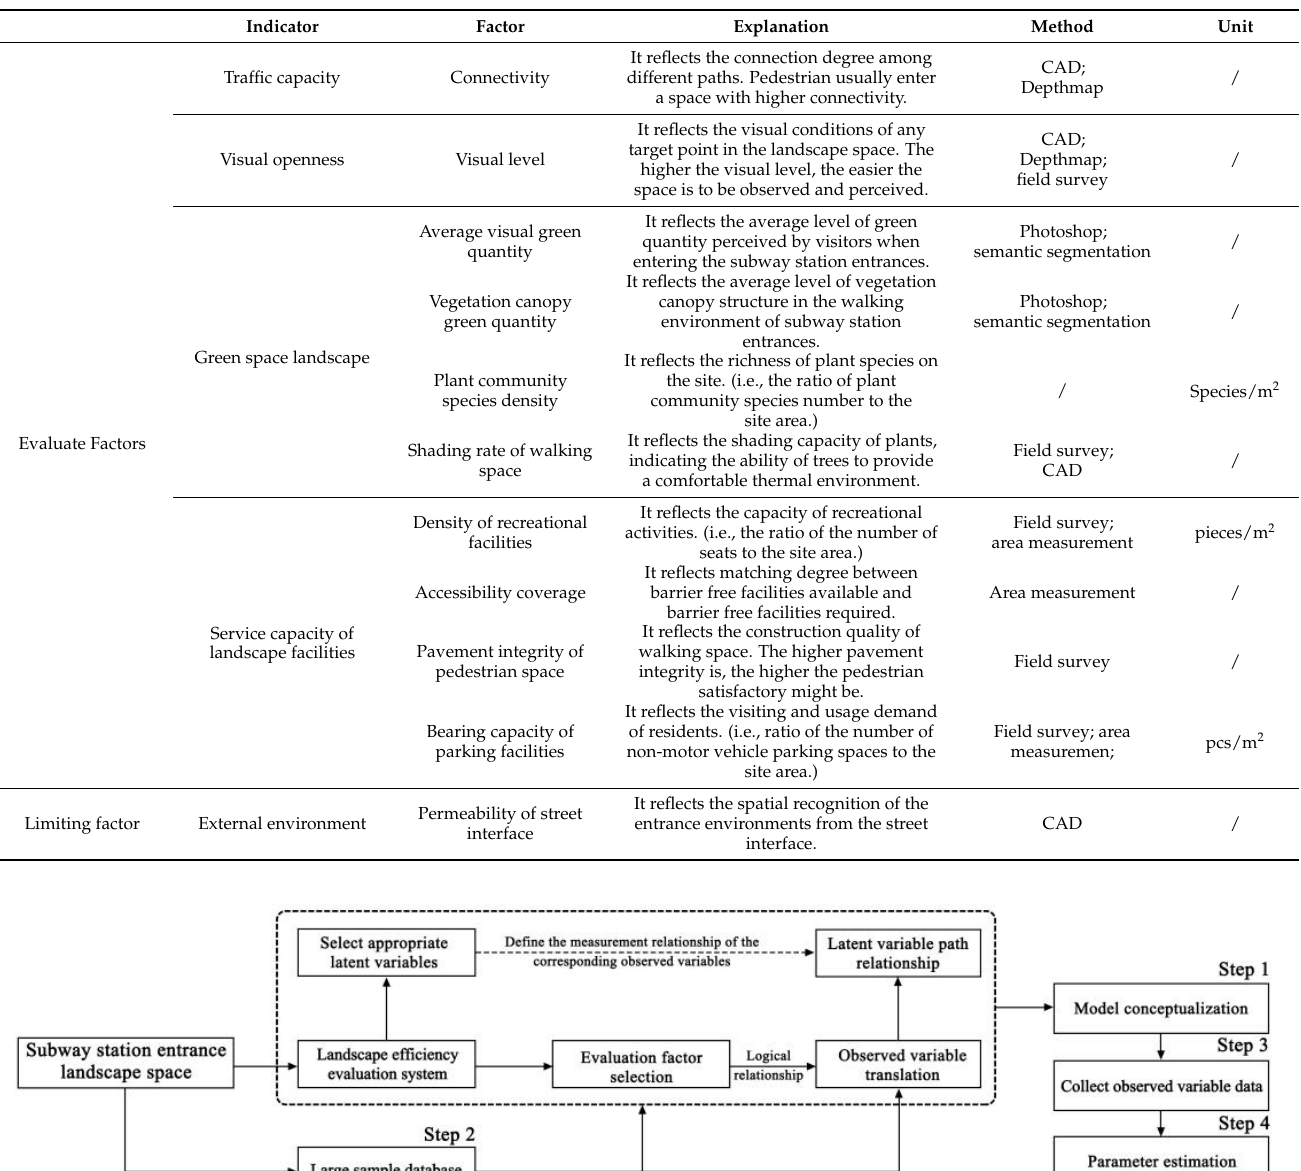
Table 1. Factor set of subway station entrance landscape efficiency evaluation system.